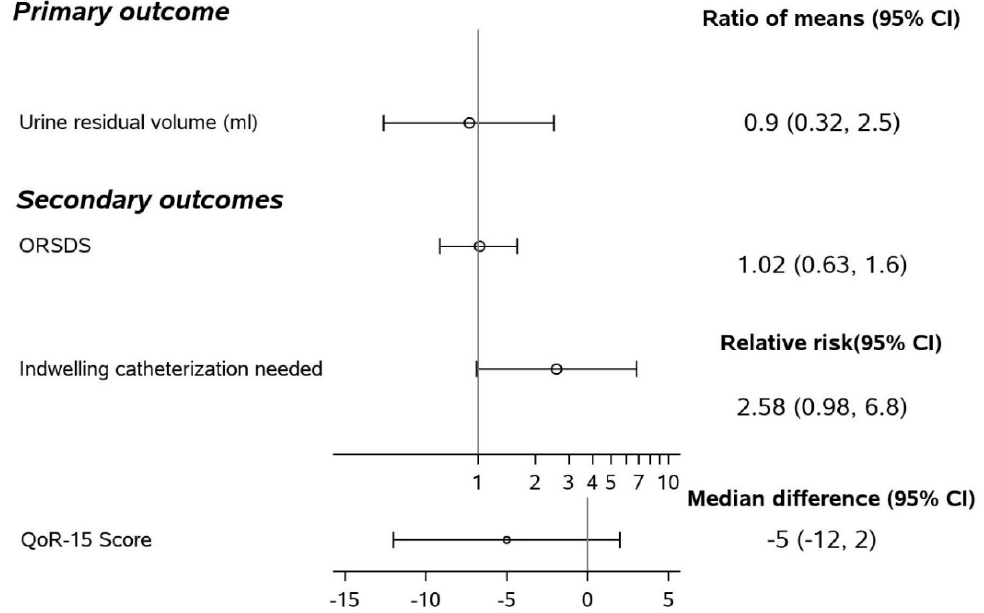
Figure 3. Forest plot of primary and secondary outcome, Naloxegol versus placebo. ORDS: Opioid–Related Symptom Distress Scale. QoR-15 score: Development and Psychometric Evaluation of a Postoperative Quality of Recovery Score.